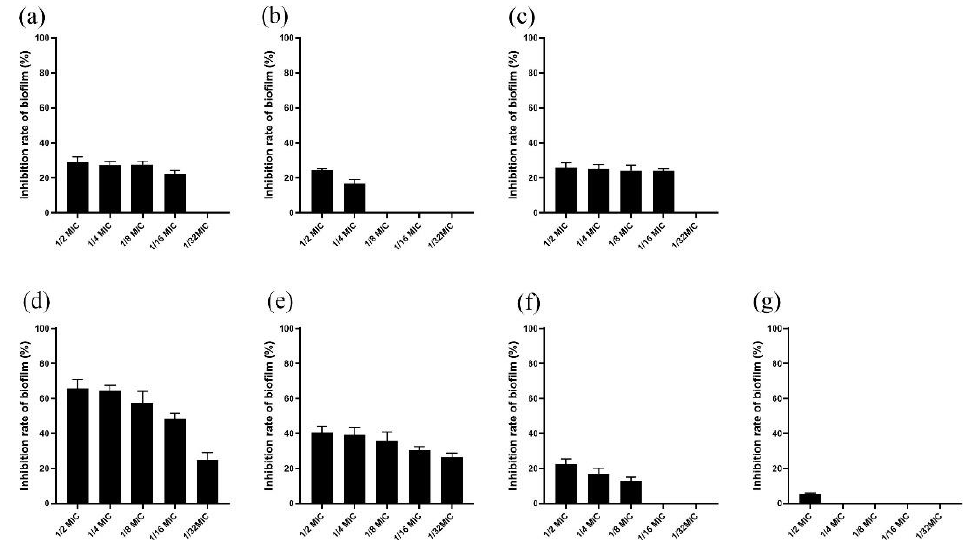
Figure 2. Biofilm formation by S. suis in the presence of sub-inhibitory concentrations of each compo- nent of peony seed meal. Biofilm was quantified by crystal violet staining following bacterial growth. From ( a ) to ( g ): ( a ): suffruticosol A; ( b ): suffruticosol B; ( c ): suffruticosol C; ( d ): paeonifloin; ( e ): albi-